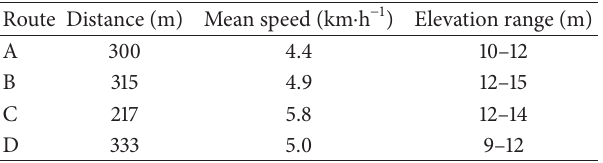
Table 1: General description of the trees in the domain. Table 2: Walking routes parameters (obtained from GPS tracking): maximum distance travelled; average walking speed; and the range Crown height range LAD of heights above mean sea level. Species (m) (m 2 ⋅ m − 3 ) Acer pseudoplatanus 1.08 6–10 and Quercus robur